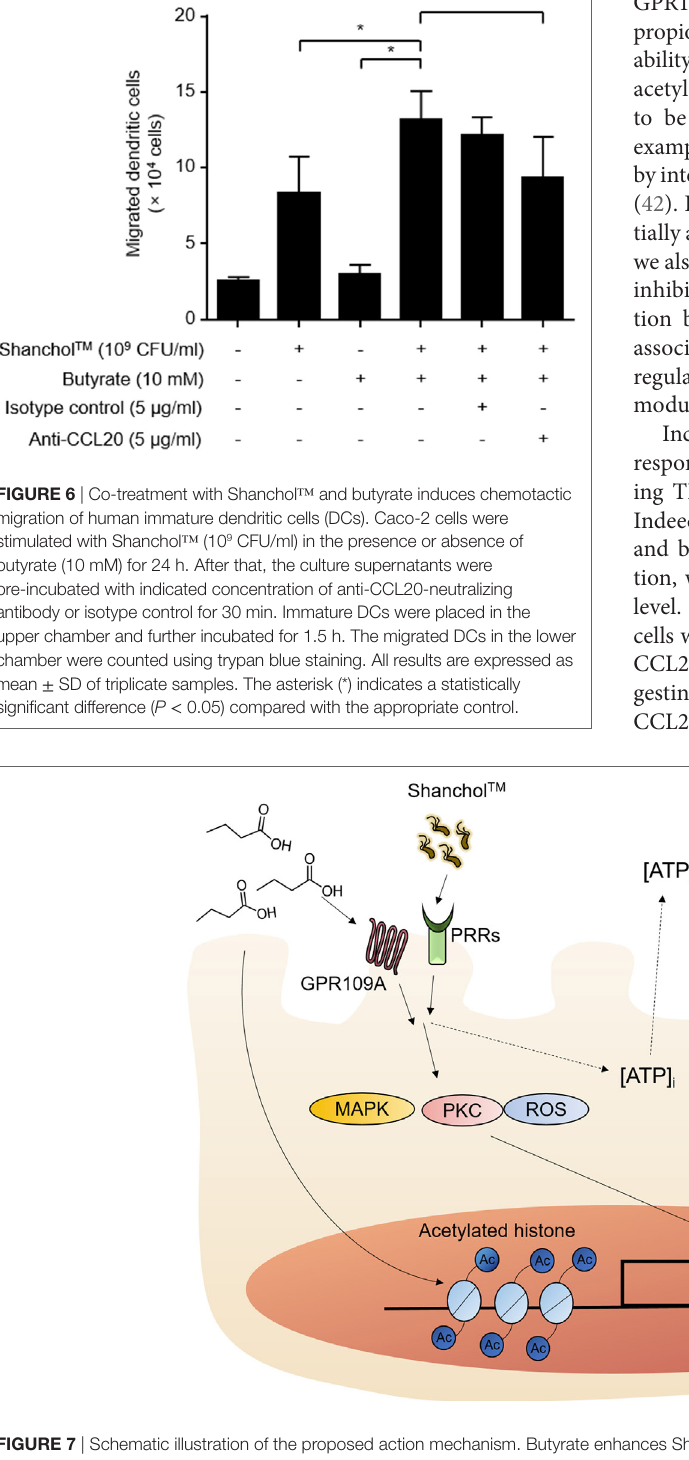
FigUre 7 | Schematic illustration of the proposed action mechanism. Butyrate enhances Shanchol ™ -induced CCL20 secretion via GPR109A, ATP-P2X7, and epigenetic control by histone deacetylase